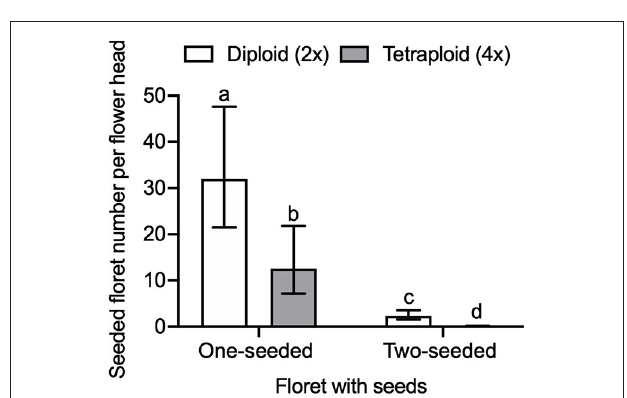
FIGURE 7 | Comparison of seeded floret number per flower head between diploid (2 × ) and tetraploid (4 × ) red clover cultivars under honey bee pollination. Error bars indicate the 95% confidence interval of the estimated marginal means (EMMs). EMMs sharing a lowercase letter within the same figure are not significantly different at 0.05 significance